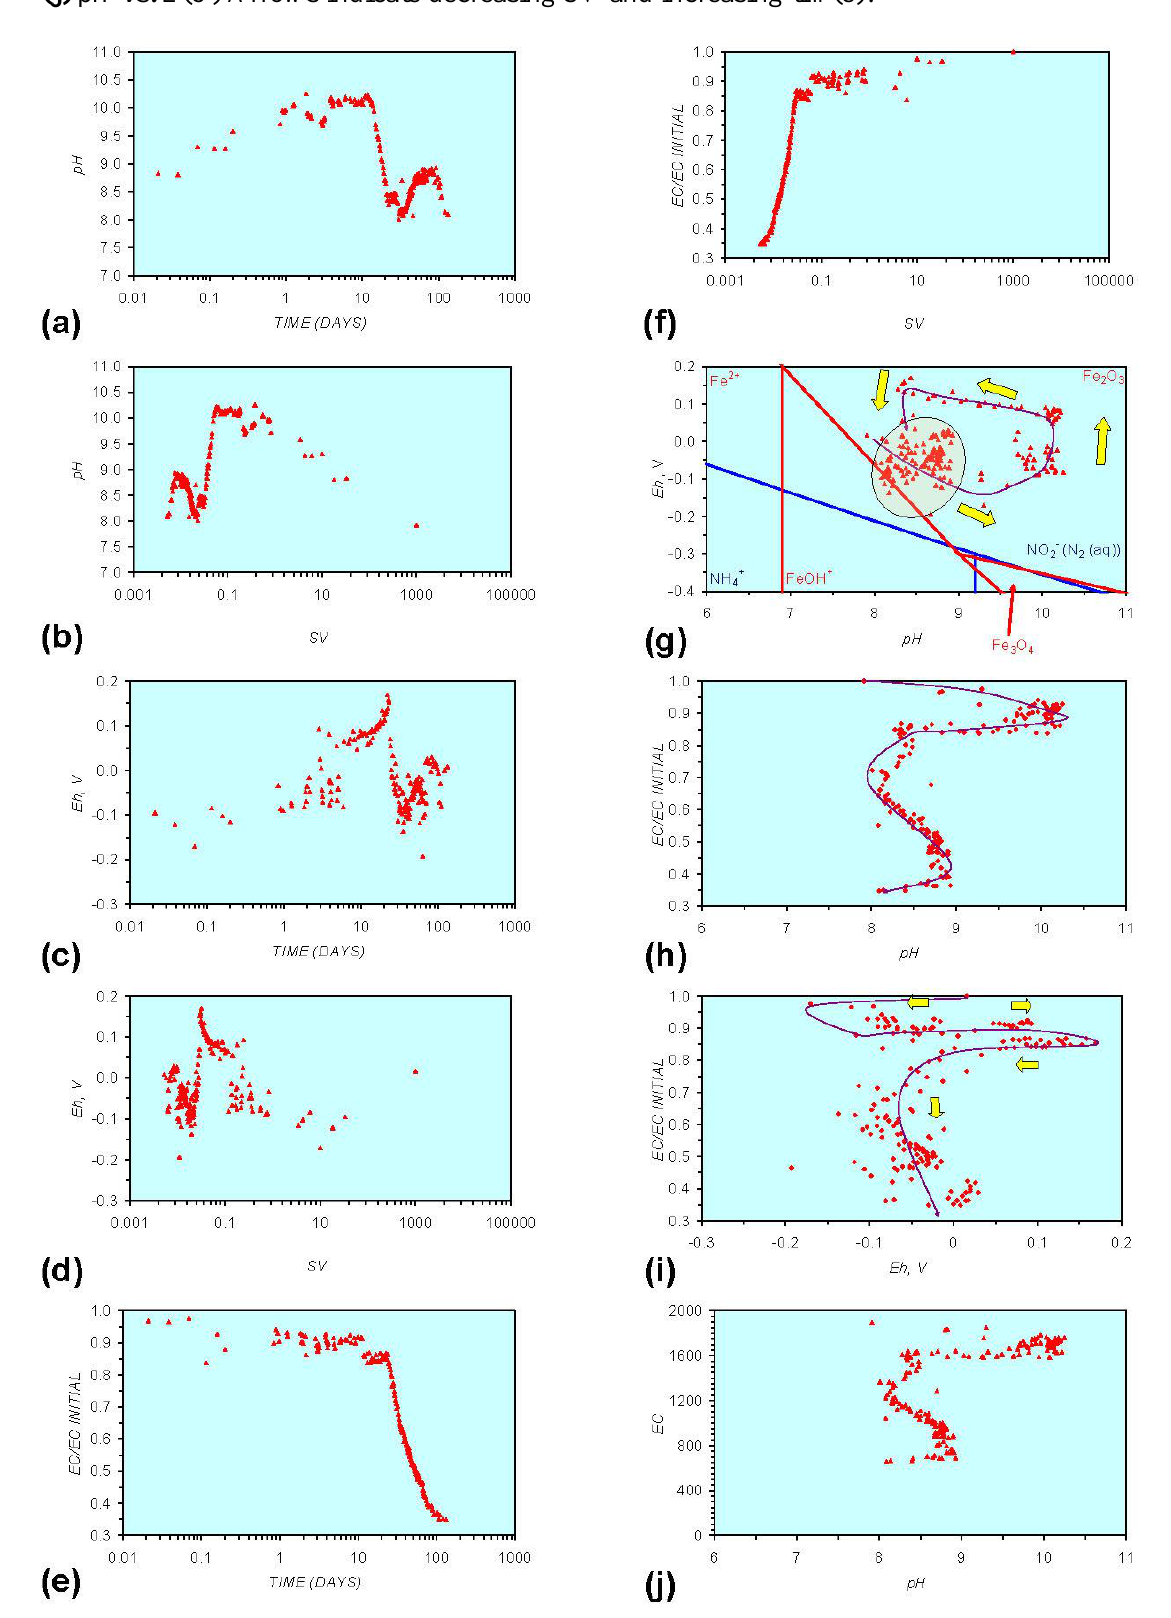
Figure A6. MR6: n-Fe 0 , fresh water containing dissolved organic matter. (a) pH vs. Time; (b) pH vs. SV; (c) Eh vs. time; (d) Eh vs. SV; (e) EC/EC Initial vs. time; (f) EC/EC Initial vs. SV; (g) Eh vs. pH (SRE ringed); (h) pH vs. EC/EC Initial; (i) Eh vs. EC/EC Initial; (j) pH vs. E(C) Arrows indicate decreasing SV and increasing